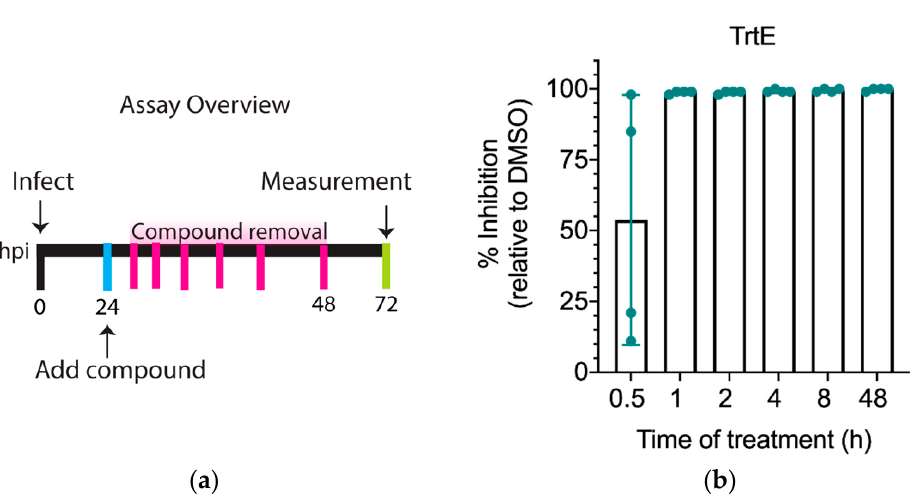
Figure 1. Drug-response curves of trtE against WT and Nluc C. parvum strains are not significantly different. ( a ) Assay overview of the in vitro growth inhibition assay in the context of a dose–re- sponse curve. ( b ) Dose–response curve of trtE against C. parvum strains determined with the log[in- hibitor] vs. response-variable slope (four parameter) regression equation. Comparative analysis of the dose response curves using the extra sum of squares F test revealed no significant difference ( p = 0.88). The data plotted are the means ± SD of four independent experiments. Table 1. EC 50 of trtE against Nluc and WT C. parvum when measured by luminescence or qPCR.